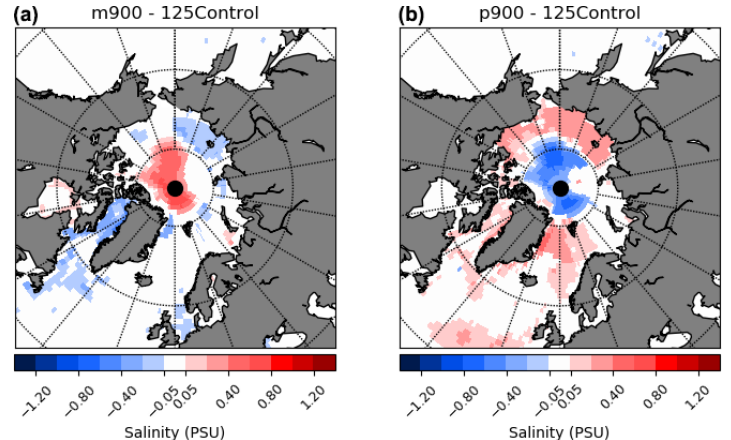
Figure A4. Annual salinity (PSU; averaged over the top 535m) anomalies for m900 (a) and p900 (b) compared to the 125Control simulation. Only the anomalies statistically significant at the 95% confidence level are displayed. Shading displays wind speed (ms − 1 ).